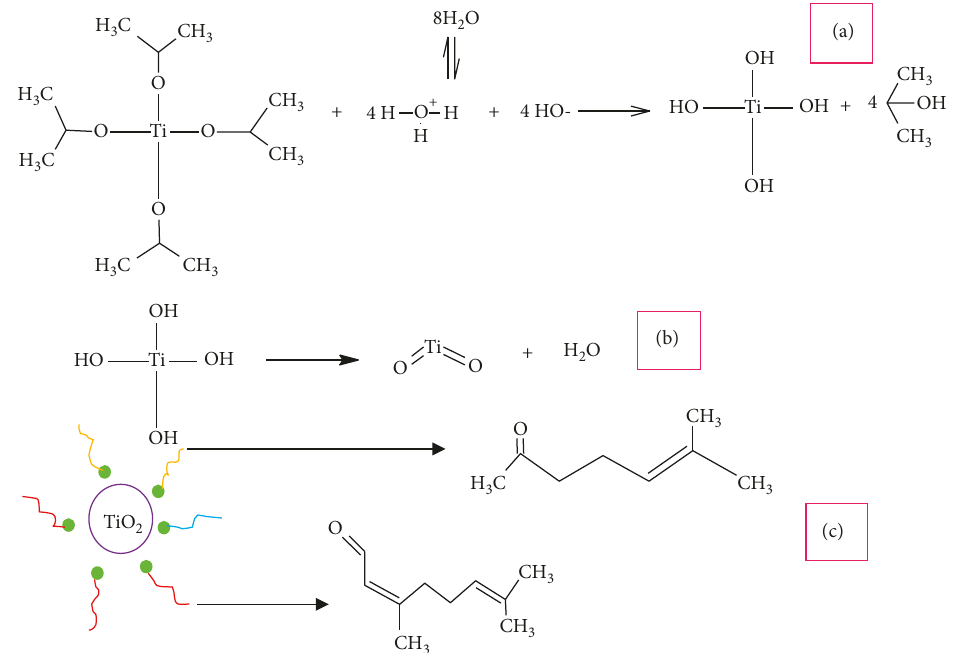
Figure 2: (a) Complete hydrolysis of the precursor; (b) condensation; (c) encapsulation/stabilization by the phytochemicals present in the aqueous extract of lemongrass (6-methyl-5-hepten-2-ona, neral, and geranial).